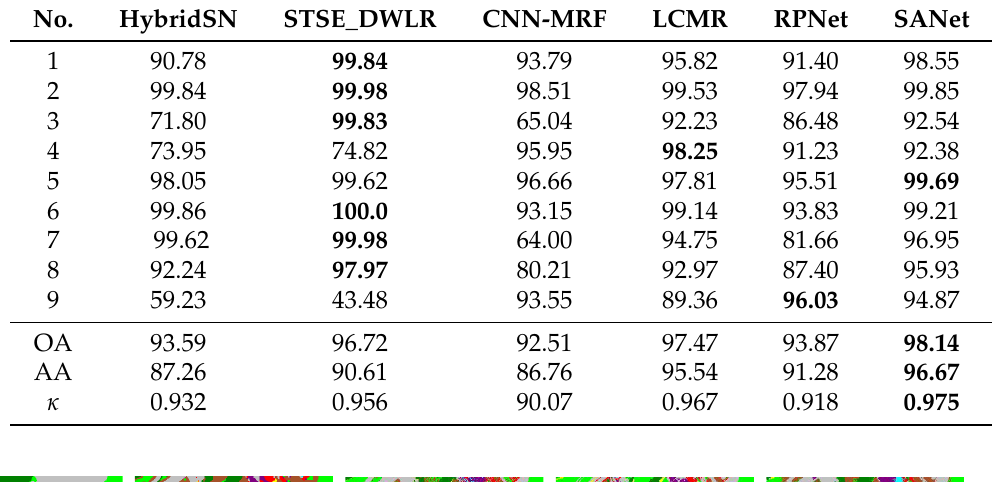
Table 3. Classification accuracies of HybridSN, STSE_DWLR, CNN-MRF, LCMR, RPNet, and SANet on the Pavia University data set. The best results are highlighted in bold font.